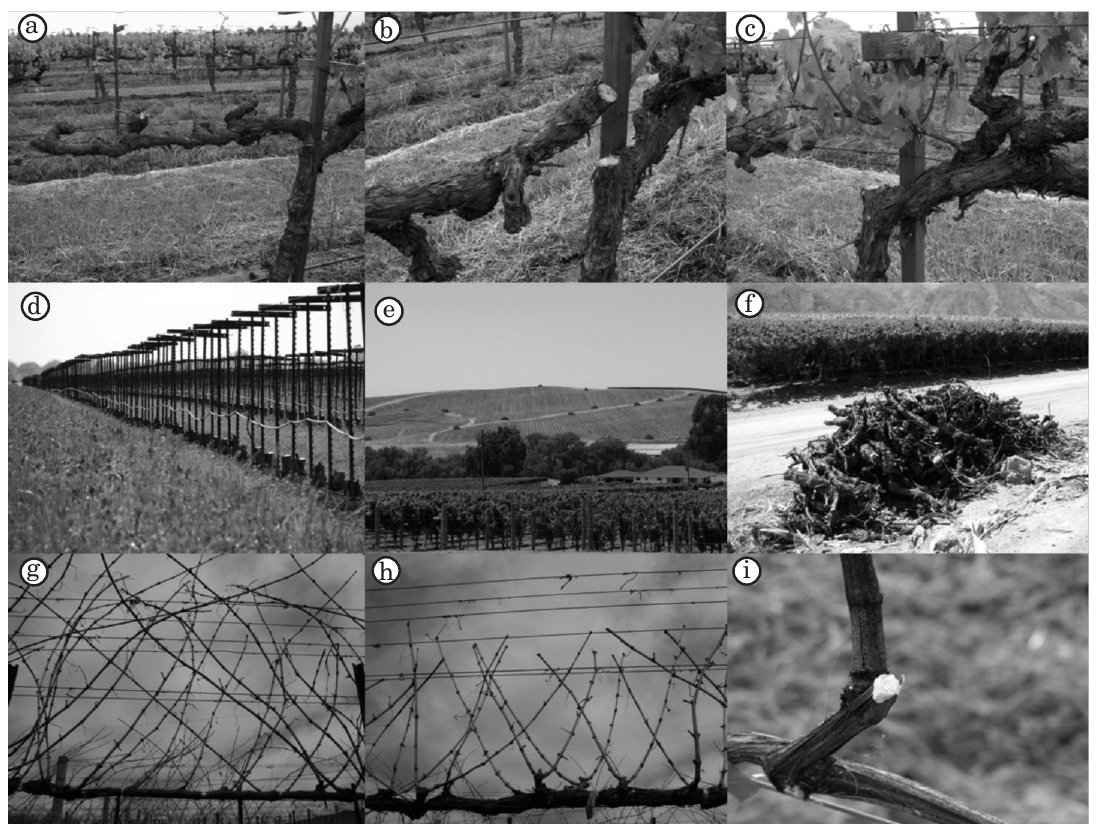
Figure 5. a–c. Remedial surgery. Pruned dead cordon and replacement by a healthy shoot located in the other healthy cordon. (Pictures courtesy of G.M. Leavitt, University of California Davis Cooperative Extension, Madera, USA). d. If infection reaches the trunk, re-training must be done from shoots from buds above the graft unions or from suckers if vines are own-rooted. e. Mature vineyards with high disease pressure make fruit production economically nonvi- able and consequently need to be eventually pulled out, which causes significant economic losses to the grapevine industry. f. All pruned debris must be eliminated from vineyards to avoid build up of inoculum. g–h. Double pruning of grapevines has been shown to reduce infections caused by Botryosphaeriaceae species in California. i. Fungicides incorporated into pruning wound sealant pastes are used to protect wounds from new